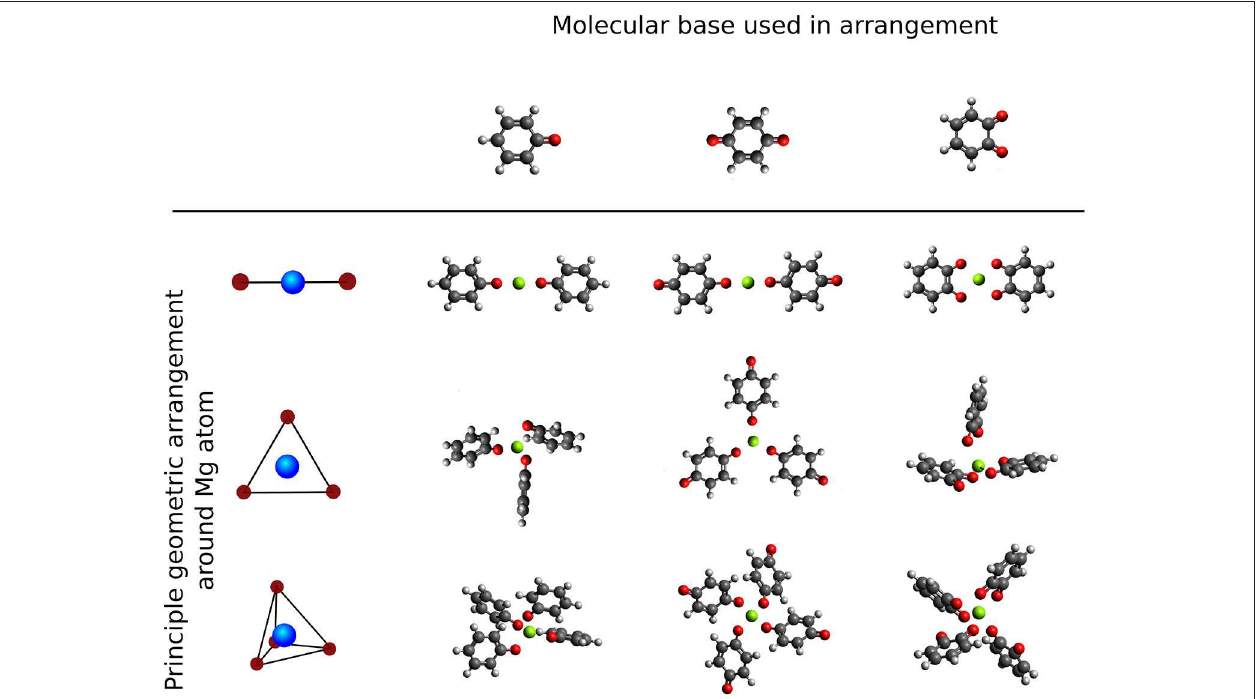
FIGURE 6 | Overview of principle high symmetry arrangements around Mg atom centers (top to bottom: single molecule, linear, trigonal and tetrahedral) with different carbonyl based 6-membered ring molecules (left to right: principle geometries, phenyloxidanyl, benzoquinone and 1,2-Benzoquinone.